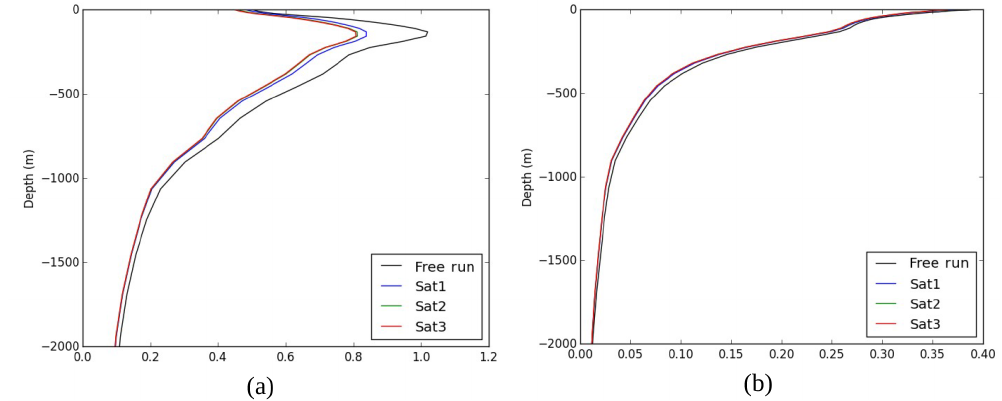
Figure 14. Global 7-day forecast RMSE of T (a) and S (b) profiles respectively in C ◦ and PSU for FR (black), Sat1 (blue), Sat2 (green) and Sat3